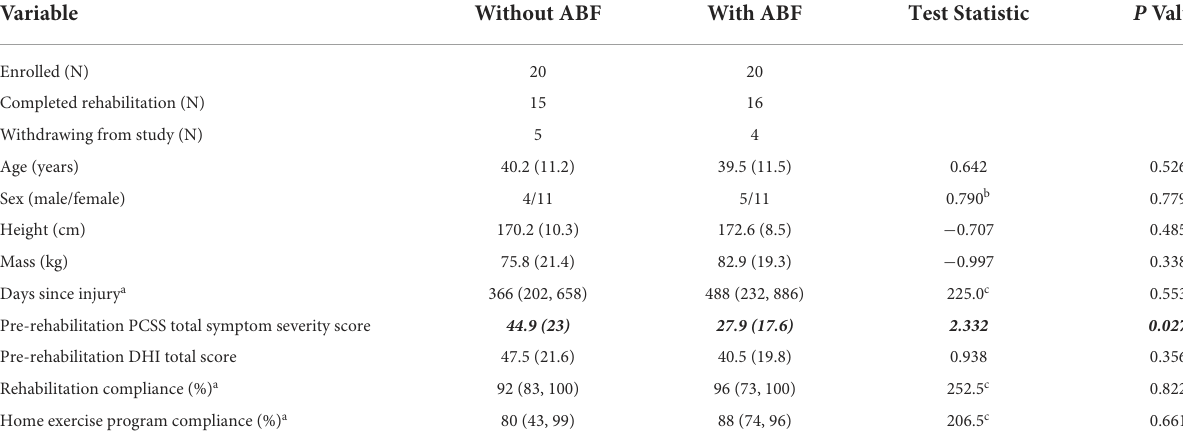
TABLE 1 Demographics for participants receiving vestibular rehabilitation with and without auditory biofeedback (ABF).